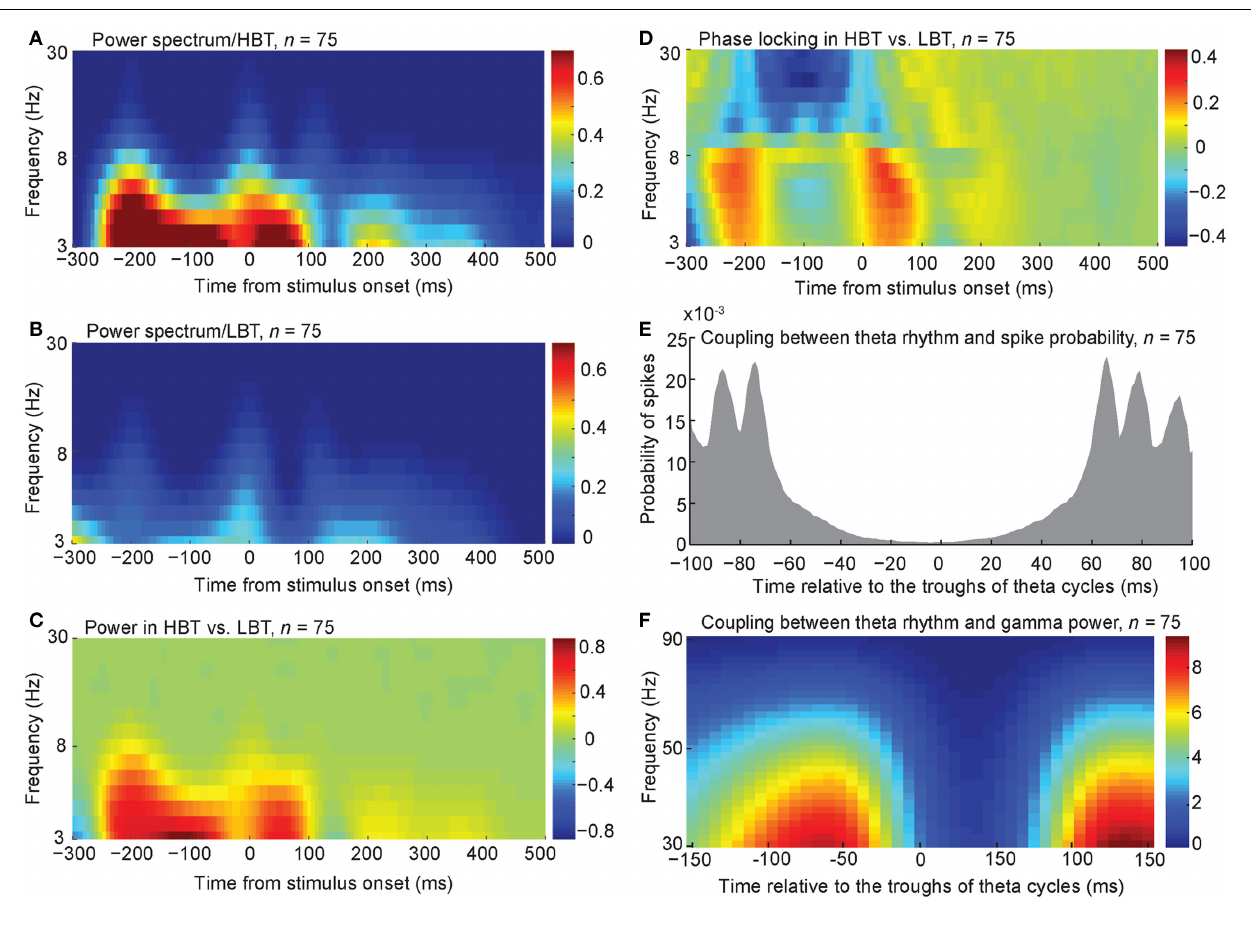
FIGURE 4 | Spectral power and phase associated with different levels of baseline activity. (A,B) The averaged spectral power of the population of body neurons in HBT (A) , and LBT (B) . (C) The difference of the spectral